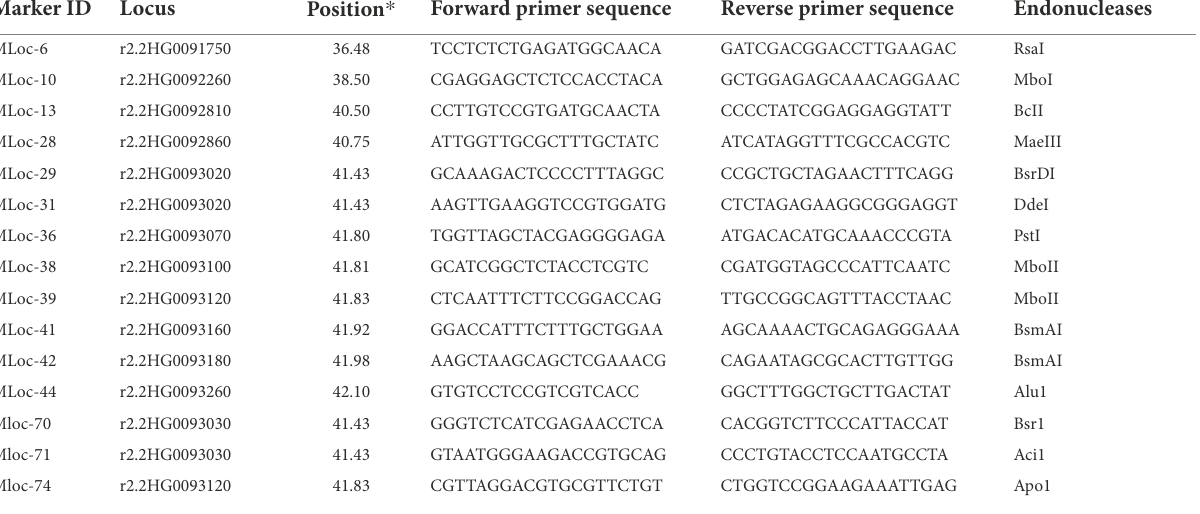
TABLE 3 Sequence information for polymorphic CAPS primers and respective restriction enzymes used to map RphAGG396